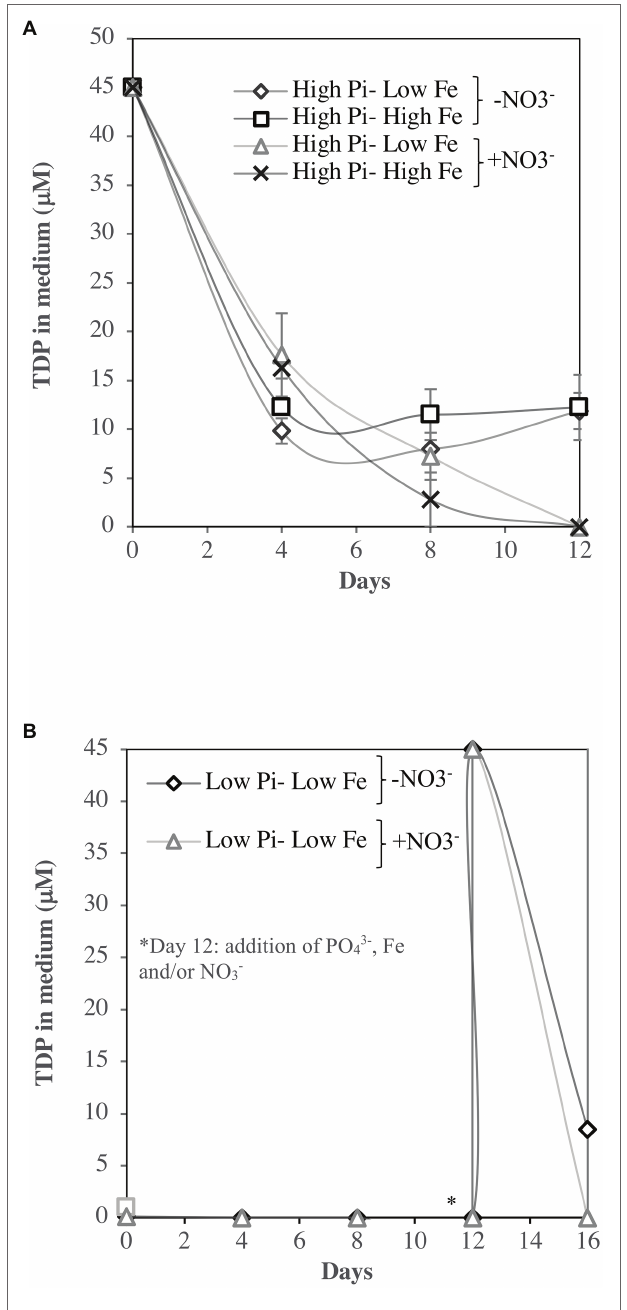
FIGURE 7 | TDP (μM)